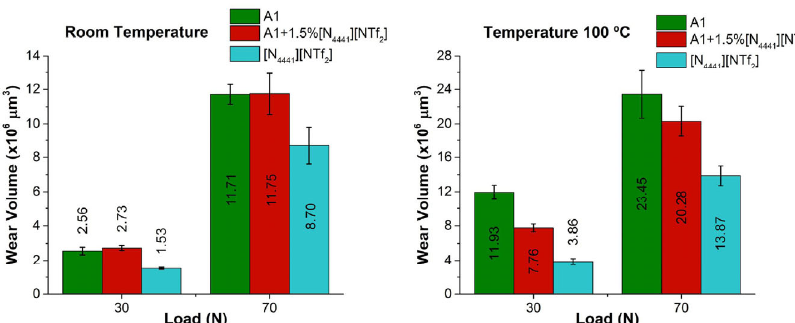
Fig. 4 Wear volume on the disk after tests made at RT and 100 °